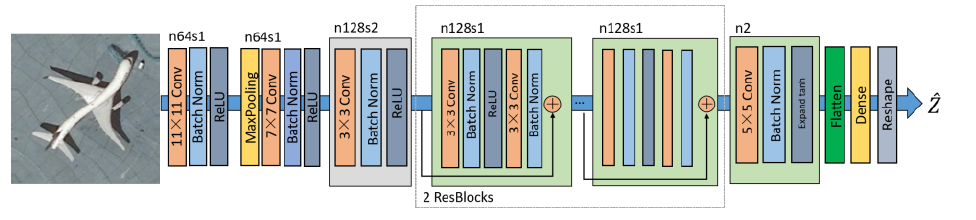
Figure 4. Architecture of the proposed generator in RestoreGAN.